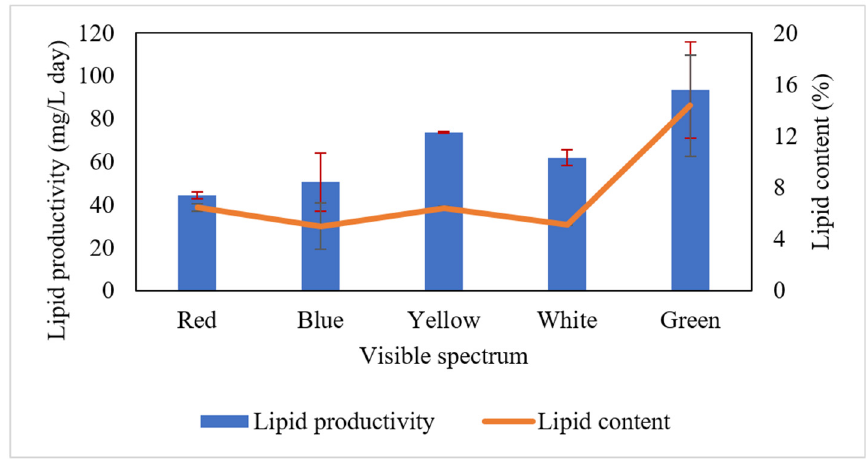
Figure 2. Lipid productivity and contents of attached microalgae growing on palm decanter cake at various visible spectra of irradiation.